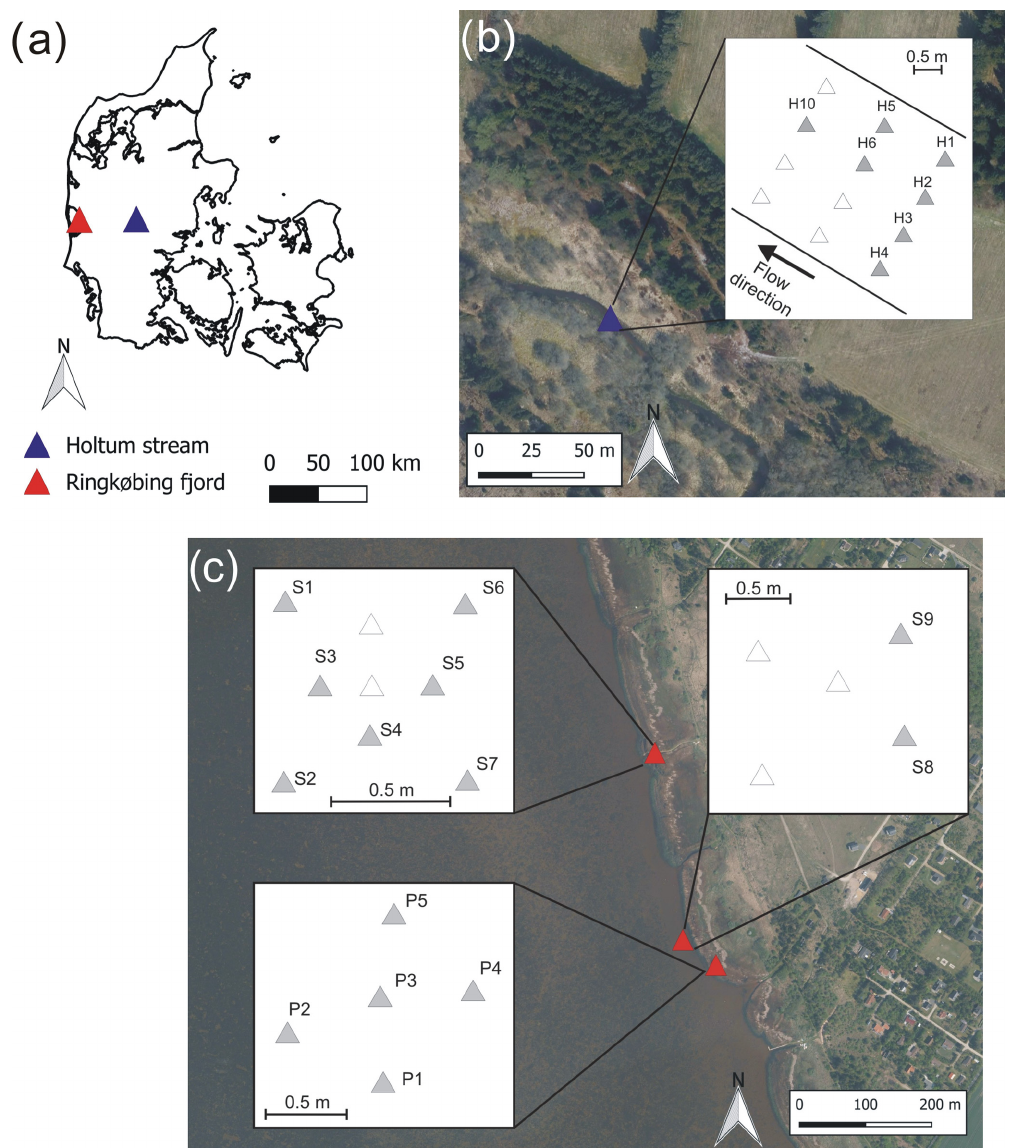
Figure 1. Location of the field sites in Denmark (a) with the location of the profiles in Holtum stream (b) and Ringkøbing fjord (c) . In panels (b) and (c) the triangles mark the locations where vertical sediment temperature profiles were measured, while the grey triangles indicate the profiles where sediment thermal conductivity was measured as well. Data from the locations marked with grey triangles are discussed in this study. Panels (b) and (c) include data from Styrelsen for Dataforsyning og